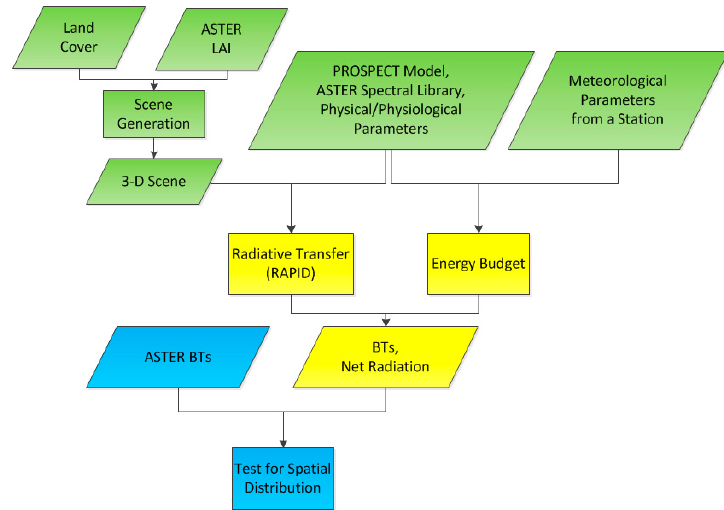
Figure 2. The scheme used to test the RAPID-EB model over the study area in this paper. The data preparation steps are indicated in green, the RAPID-EB model and its outputs are indicated in yellow, and the test steps are indicated in blue.